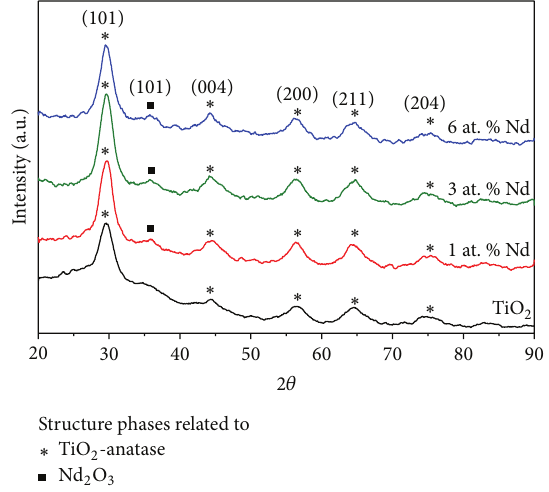
Figure 4: XRD patterns (Co K 𝛼 radiation) of TiO 2 and TiO 2 :Nd nanoparticles prepared by sol-gel